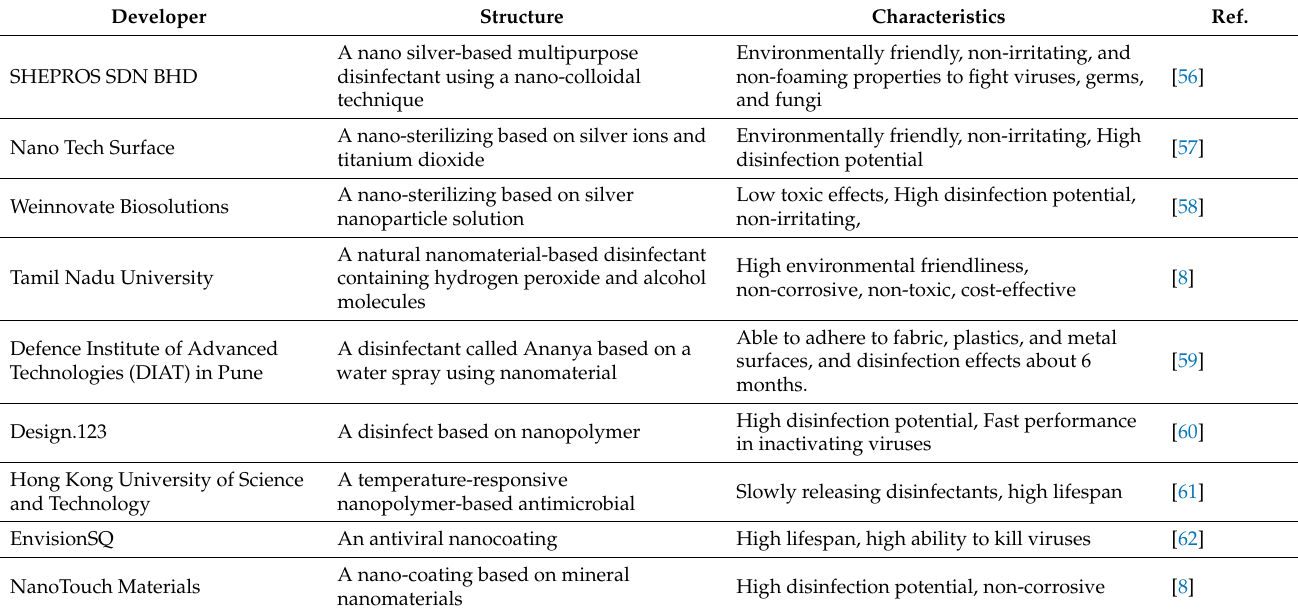
Table 1. Sterilization and disinfection of inanimate surfaces based on nanotechnology. Developer Structure